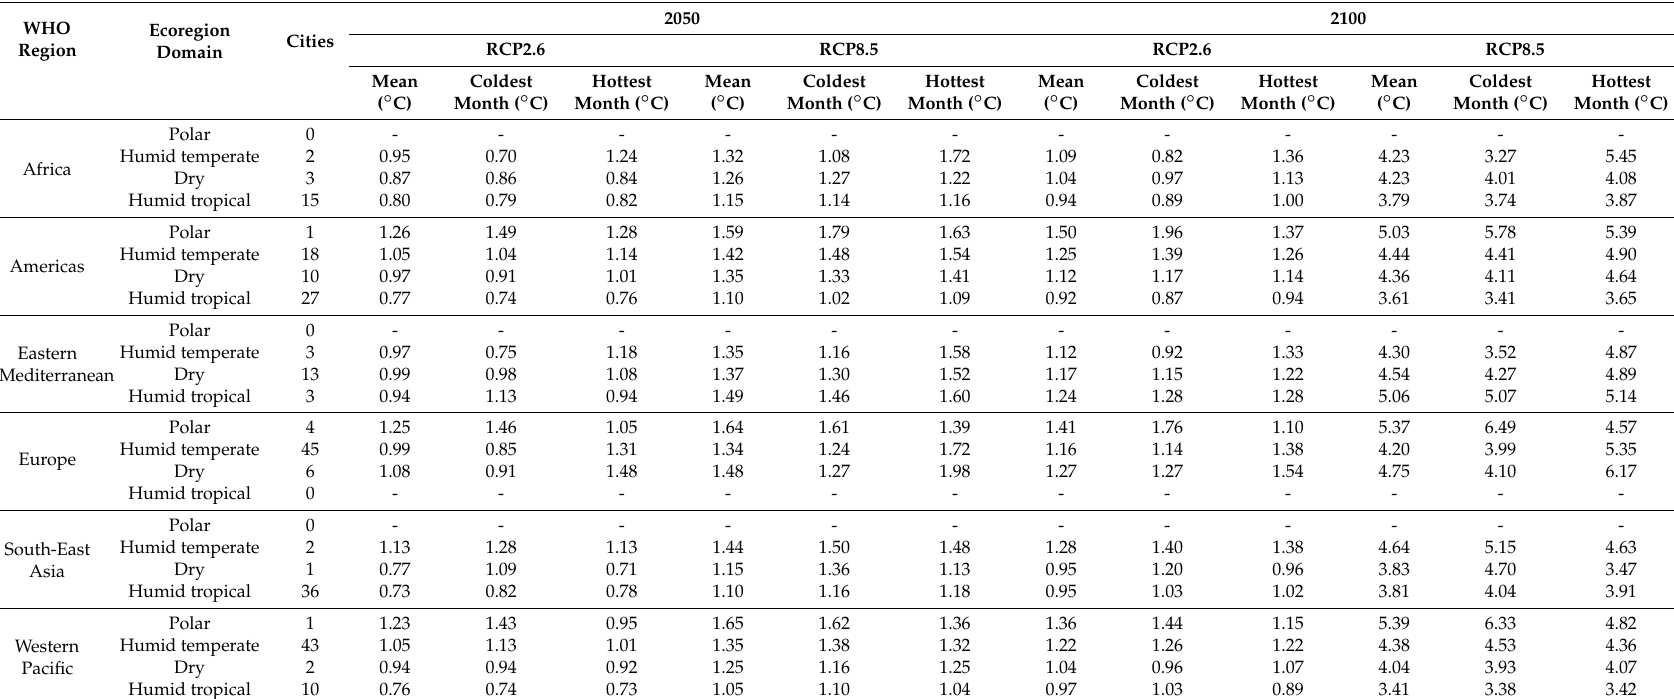
Table 3. Average of GCM estimates of changes in T mean by 2050 and 2100 (relative to